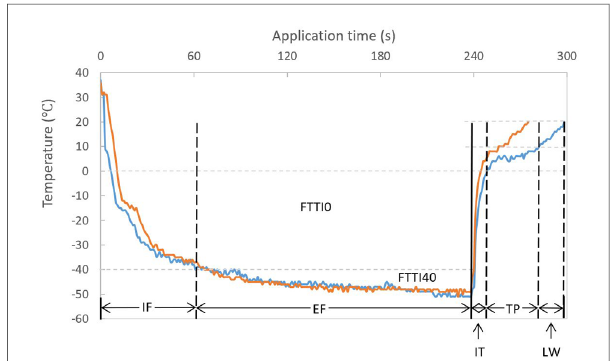
FIGURE 1 Temperature-time curve during a cryoballoon ablation and descriptions of stages. Similar temperature and time interval during freezing but a short (orange) and long (blue) TP time during thawing are demonstrated. EF, effective freezing; FTTI0, freezing-temperature- time integral under 0°C; FTTI40, freezing-temperature-time integral under − 40°C; IF, initial freezing; IT, initial thawing; LW, late warming; TP, thawing plateau. Partition and annotation are based on the blue curve (de fi nition see “ Methods ” ).